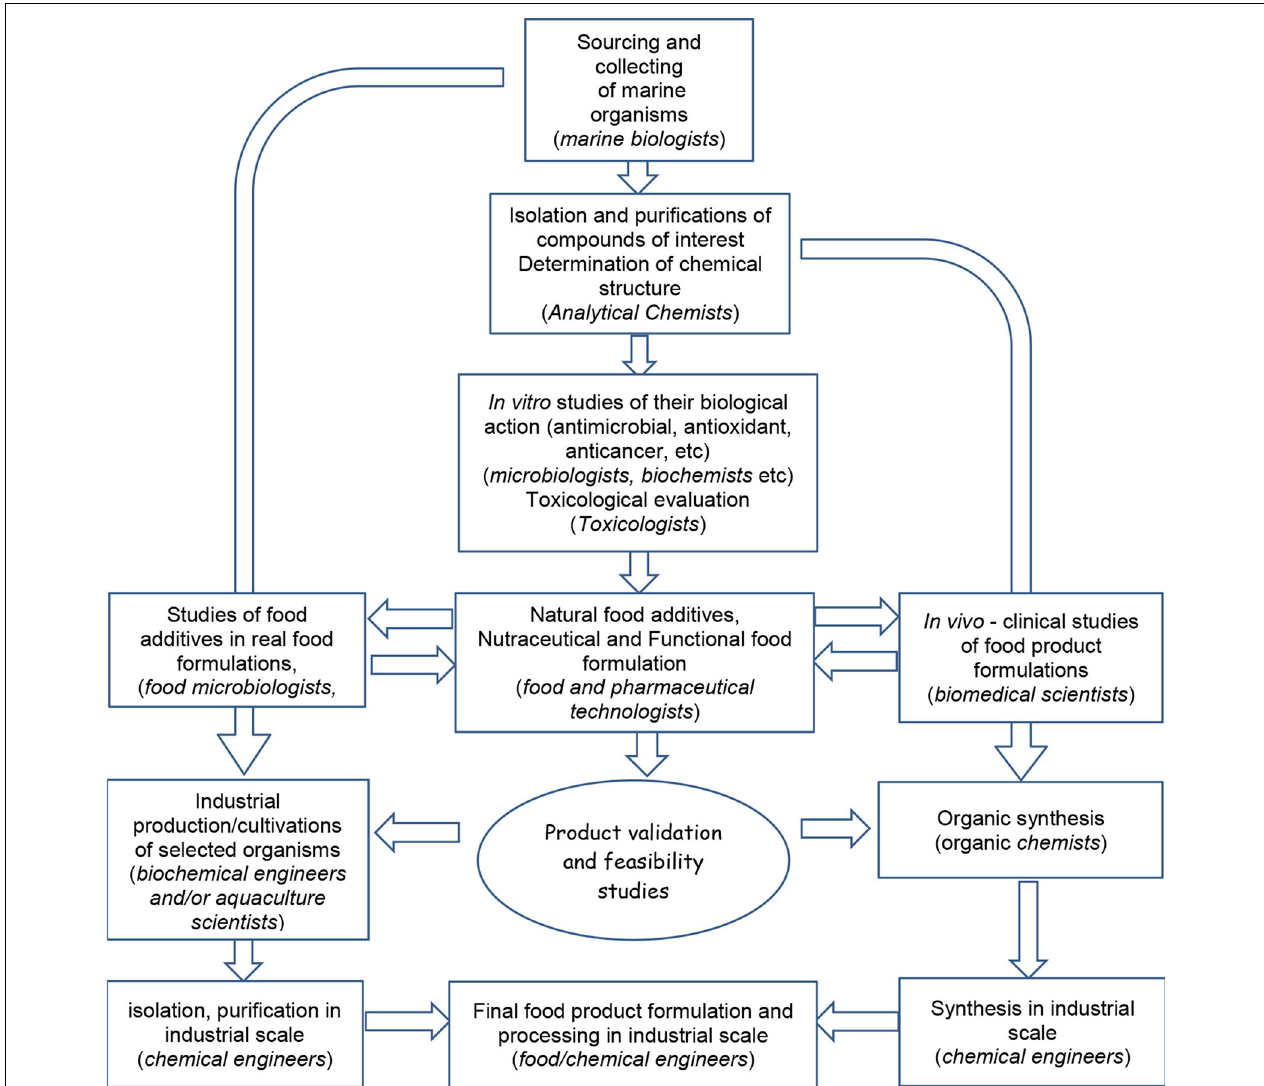
FIGURE 1 | Potential actions and disciplines that might be required for the optimal exploitation of marine bioactive compounds for food use.